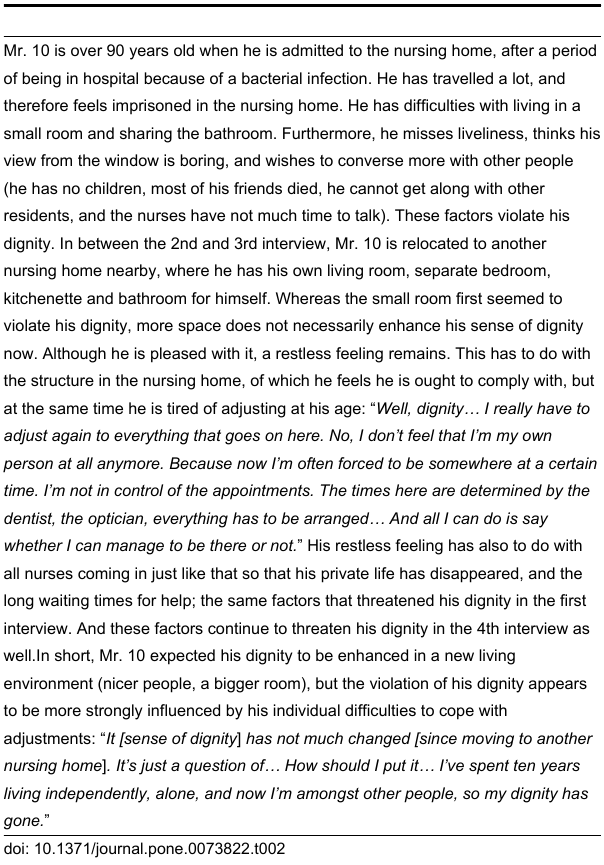
Table 1. Characteristics of respondents. Table 2. No change in personal dignity: Mr.